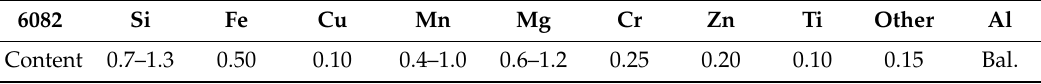
Table 1. The chemical composition of the 6082 Al alloy (in